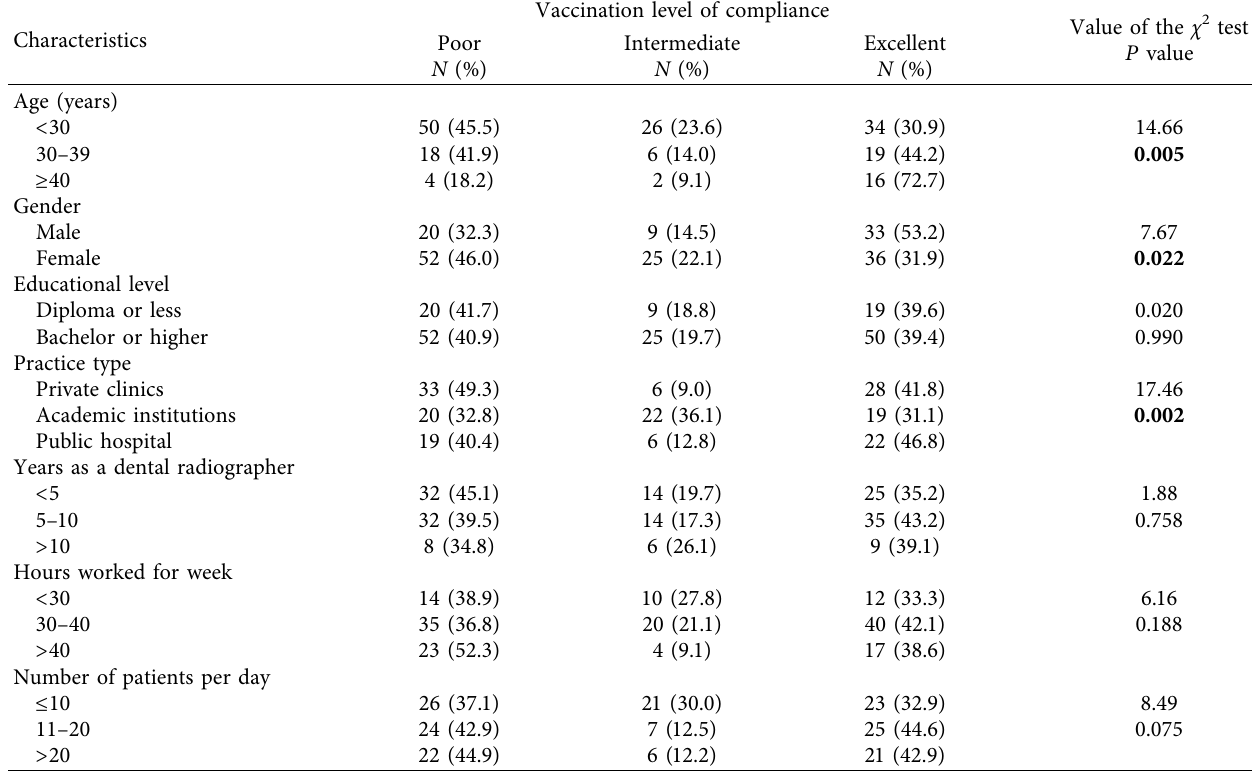
Table 3: The level of compliance with vaccination practices ( N �